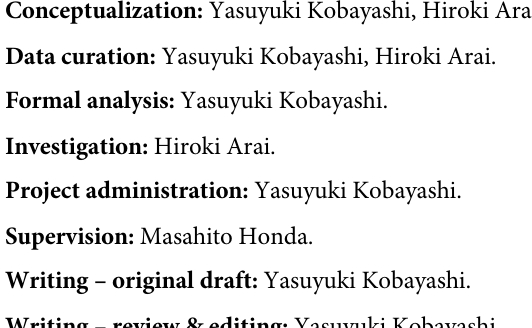
S1 Table. Prospective randomized trials of enucleation surgery of the prostate. S2 Table. Supporting information data